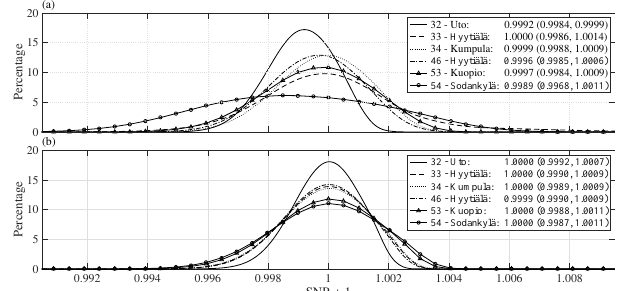
Figure 10. Histograms showing the (a) uncorrected and the (b) cor- rected background SNR for the upper 20% range bins of the Halo Doppler lidar units in different locations. The specific measurement periods for the different locations are given in Table